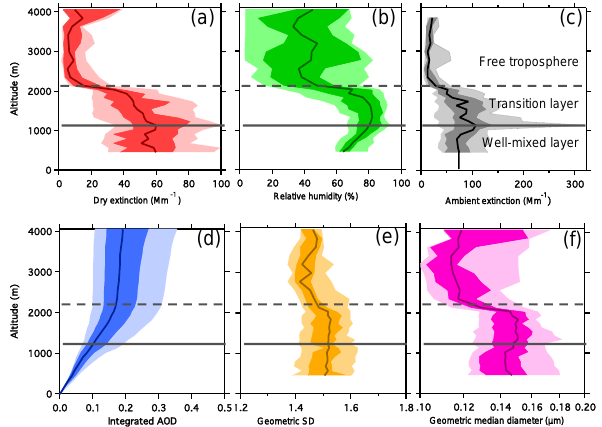
Figure 1. Aggregate vertical profiles of (a) dry extinction at stan- dard temperature and pressure, (b) relative humidity, (c) extinction at ambient RH, pressure and temperature, (d) ambient aerosol op- tical depth integrated from the surface upward to the indicated al- titude, and (e) number geometric median diameter and (f) geomet- ric standard deviation for a single-mode lognormal size distribu- tion calculated from the measured dry particle number size dis- tribution. Light shading shows the interdecile (10 to 90%) range, dark shading the interquartile (25 to 75%) range, and the solid line the median value. The horizontal solid and dashed lines show the tops of the well-mixed and transition layers, respectively. The solid vertical line in (c) shows the extrapolation of ambient extinction to ground level to calculate AOD. Note the scale difference be- tween (a) and (c) .